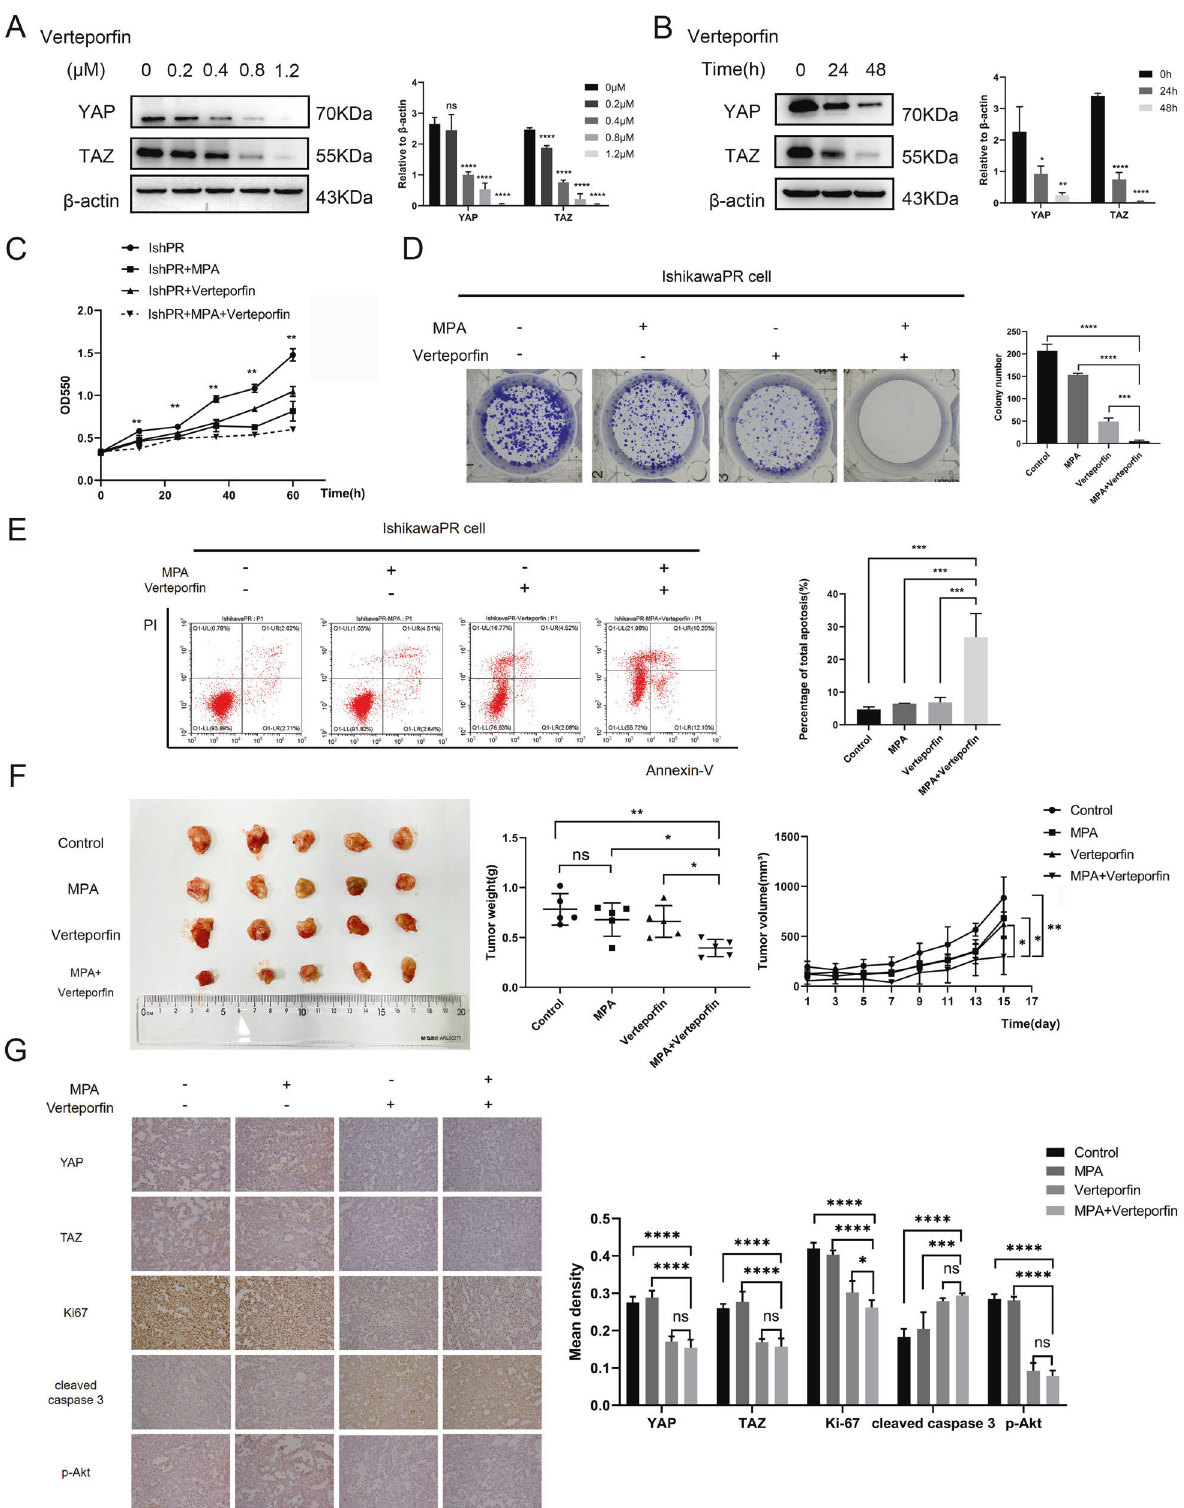
Fig. 6 Combination of Vertepor fi n and MPA increases the lethal effects on EC in vivo and vitro. A , B The inhibition of YAP/TAZ by Vertepor fi n in dose-dependent and time-dependent manners by western blotting assay. C The growth curves of IshikawaPR cells after treated with medium, MPA, Vertepor fi n, or MPA plus Vertepor fi n. ** P < 0.01 IshikawaPR cells treated with medium vs IshikawaPR cells treated with MPA plus Vertepor fi n. D The colony formation ability of IshikawaPR cells with treatment of medium, MPA, Vertepor fi n, and MPA plus Vertepor fi n. E The apoptosis of IshikawaPR cells with treatment of medium, MPA, Vertepor fi n or MPA plus Vertepor fi n detected by fl ow cytometry assay. F The effects of Vertepor fi n, MPA, and MPA plus Vertepor fi n on tumors growth in vivo. G Representative images of IHC staining of YAP, TAZ, Ki67, cleaved caspase 3, and p-Akt in tumor tissues. * P < 0.05, ** P < 0.01, *** P < 0.001 and **** P < 0.0001.